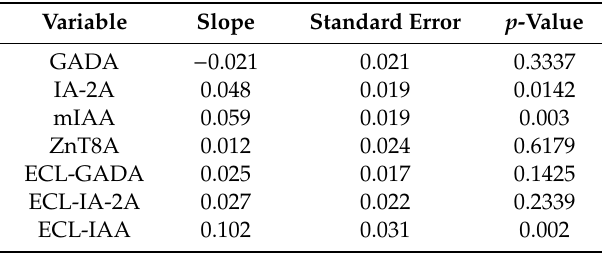
Table 2. Association of Unmethylated INS Ratio with iAb Levels Close to Onset (within 0 – 2 months prior to diagnosis).